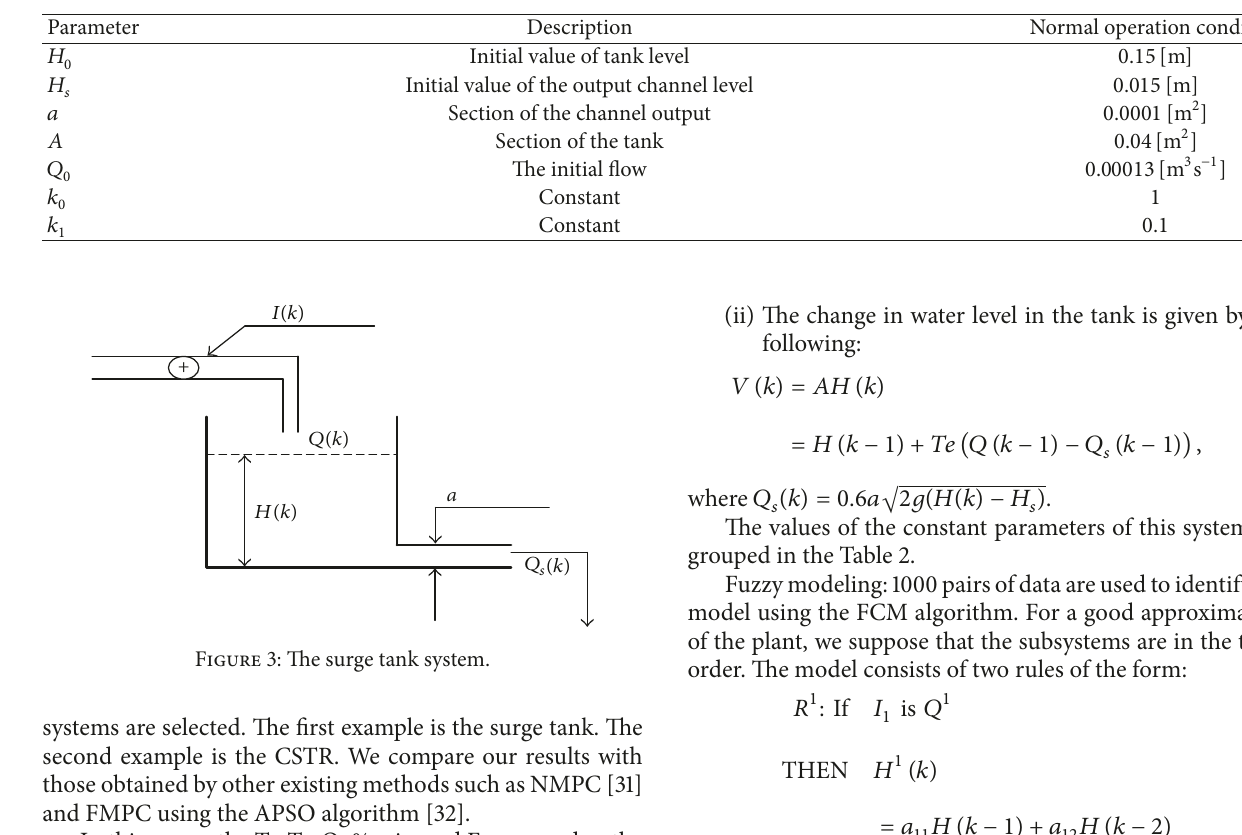
Algorithm 2: Procedure of weight parameter optimization. Table 2: Specification of the surge tank.